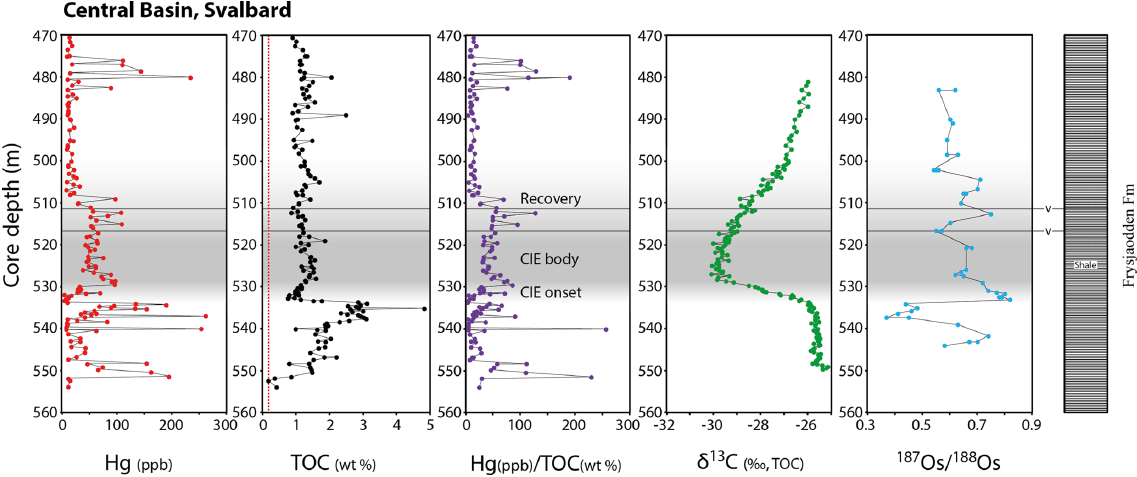
Figure 4. Mercury (Hg), TOC, Hg / TOC, δ 13 C TOC , and 187 Os / 188 Os data from sections of the BH09/2005 core from the Central Basin in Svalbard. The colouring system for Hg, TOC, Hg / TOC, and δ 13 C TOC is the same as in Fig. 3, while 187 Os / 188 Os values are shown in light blue. The carbon isotope data and stratigraphic log are from Charles et al. (2011), while the Os isotope data are from Wieczorek et al. (2013). The grey shaded area shows the approximate onset, body, and recovery phases of the CIE. Identified tephra layers are shown as dark grey bands across the figure. The first of the two tephra layers has been radioisotopically dated to 55 . 785 ± 0 . 086Ma (Charles et al., 2011). The red dashed line in the TOC graph denotes the recommended threshold for TOC concentrations to report Hg / TOC values (Grasby et al.,